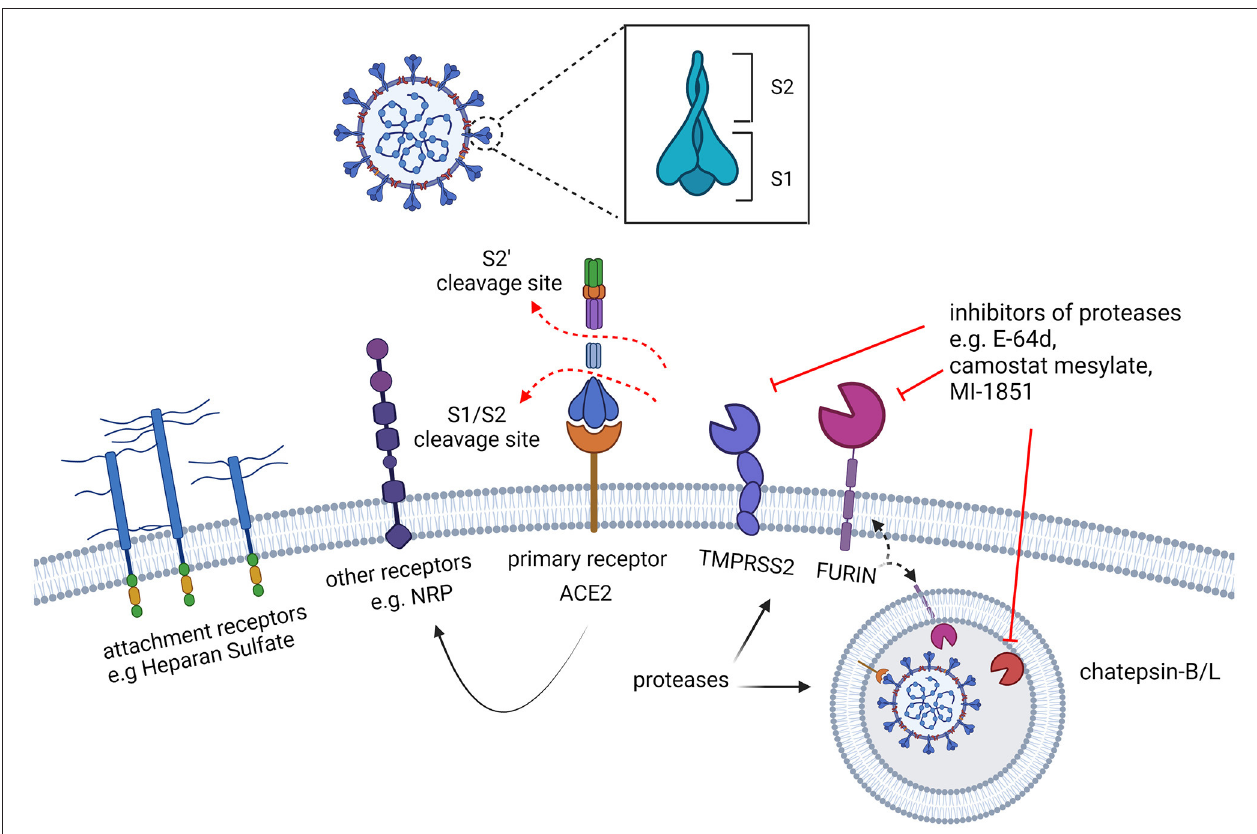
FIGURE 4 | Early interactions of SARS-CoV-2 with the target cells. The spike protein of SARS-CoV-2 recognizes surface receptors to bind and fuse with the cell. A preliminary interaction of the virus particle with the cell is mediated by attachment to cell surface glycans, such as heparan sulphate, followed by the interaction with specific receptors. While the human angiotensin-converting enzyme 2 (hACE2) is the main receptor recognized by the spike, other cell surface proteins, such as NRP, are also known to serve as receptors capable of triggering virus entry. The activation of the fusogenic activity of the spike protein also requires proteolytic processing by cellular proteases which are located on the cell surface or in the endosomal vesicles. Furin is required for the cleavage which separates the S1 and S2 subunits of the spike, predisposing the protein to the interaction with ACE2 and to the subsequent cleavage (S2’) by the activating proteases: TMPRSS2, exclusively located at the cell surface, and cathepsins, in the